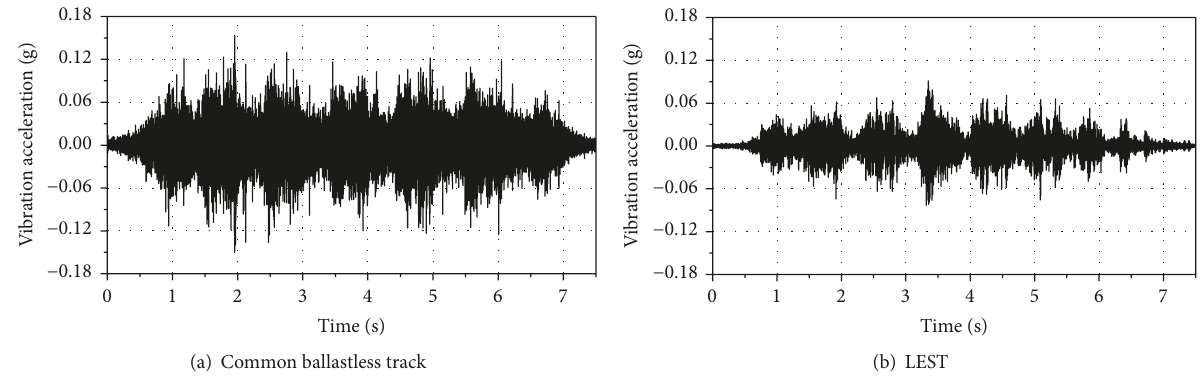
Figure 11: Typical time-history curves of vibration accelerations of point on the tunnel wall at 1.5 m height in straight track.